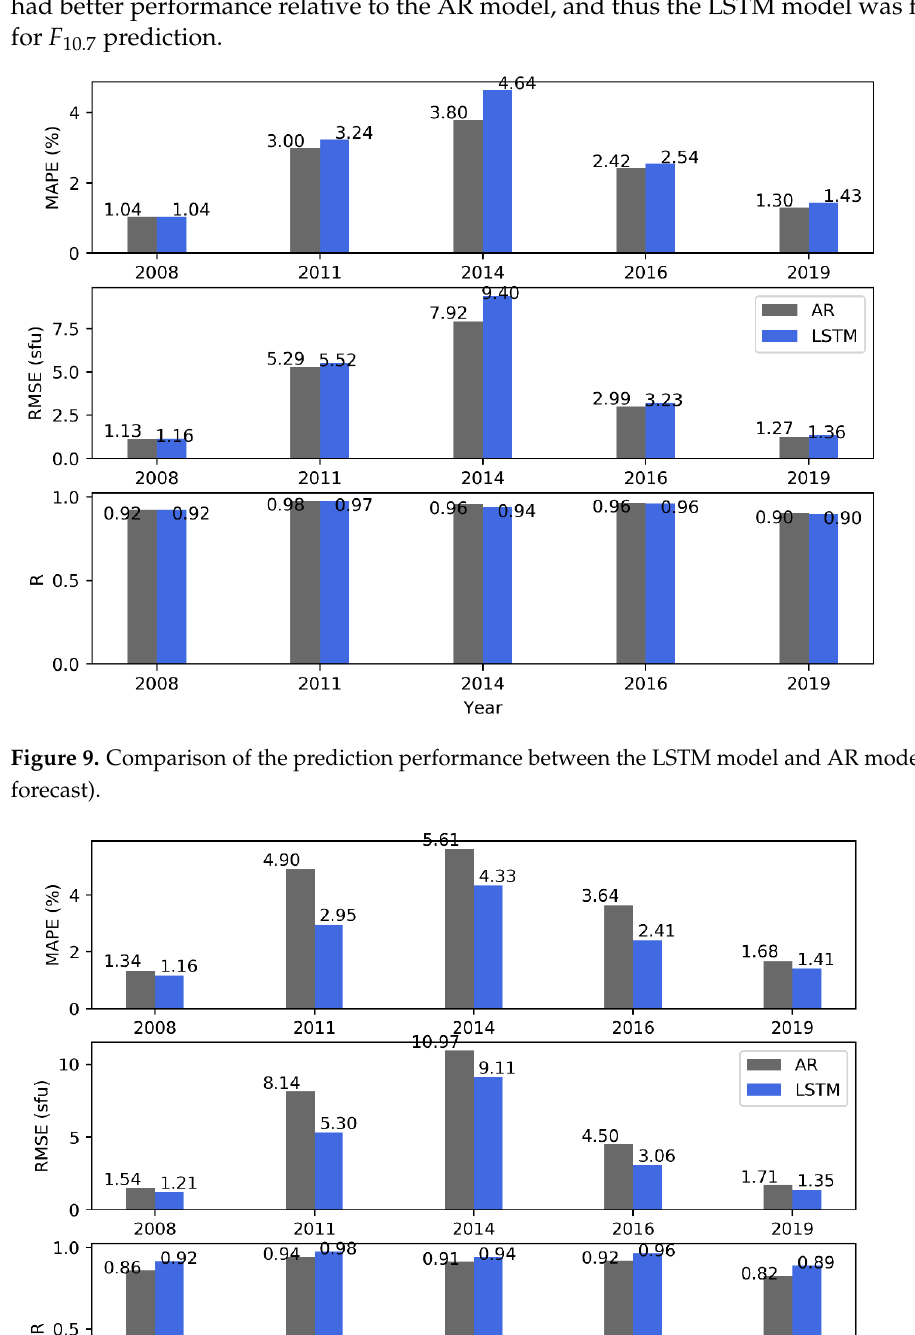
Figure 11. The same as Figure 9 but for 3-day prediction of models.